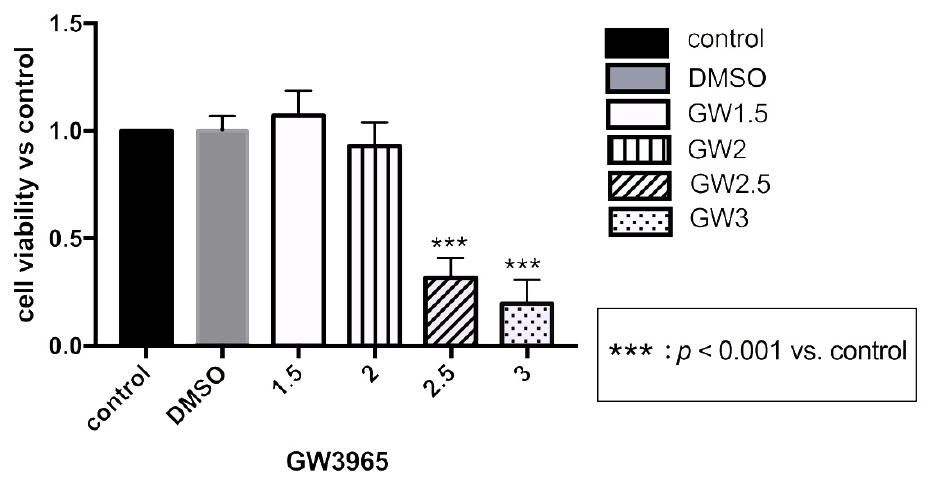
Figure A1. Assay after GW3965 treatment in ARPE-19 cells. ARPE-19 cells were cultured with DMSO, different concentrations of GW3965 or nothing in serum-free medium for 48 h. Cell viability was measured and quantified. Data are represented as mean ± SEM of three independent experiments. Differences with p < 0.05 were considered statistically significant.